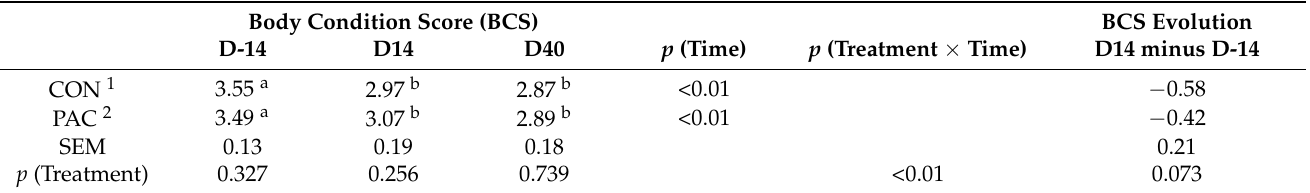
Table 2. Body condition scores of cows receiving plant bioactive compounds from D-15 to D+7 relative to